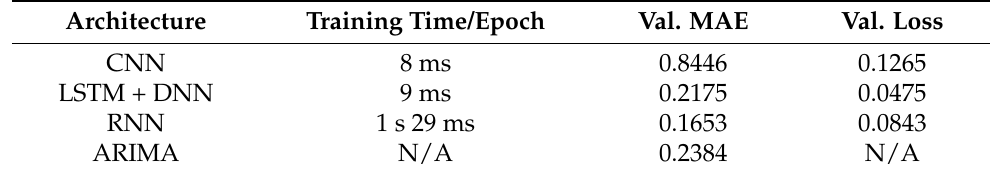
Table 5. Training times and losses for each